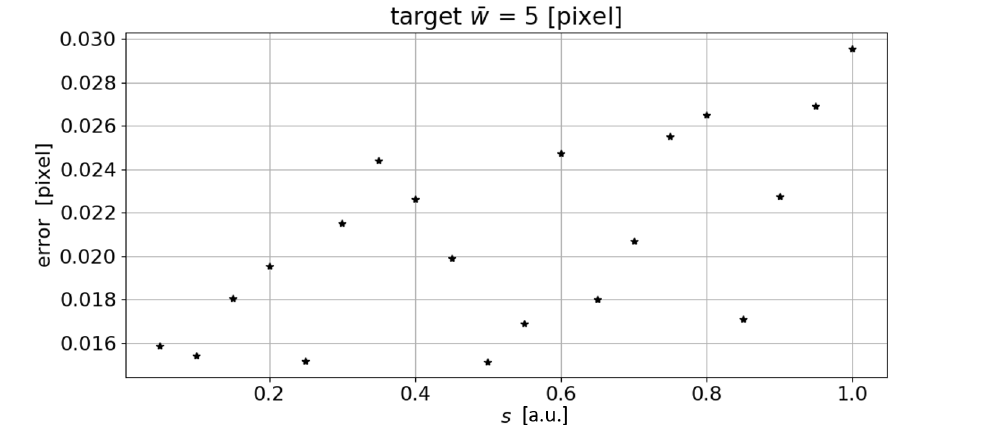
Figure 4. Variation of the absolute error in the measurement of the line mean width as the step s changes for the autonomous measurement of ¯ w , according to the procedure described in Figure 2. (a.u.: arbitrary